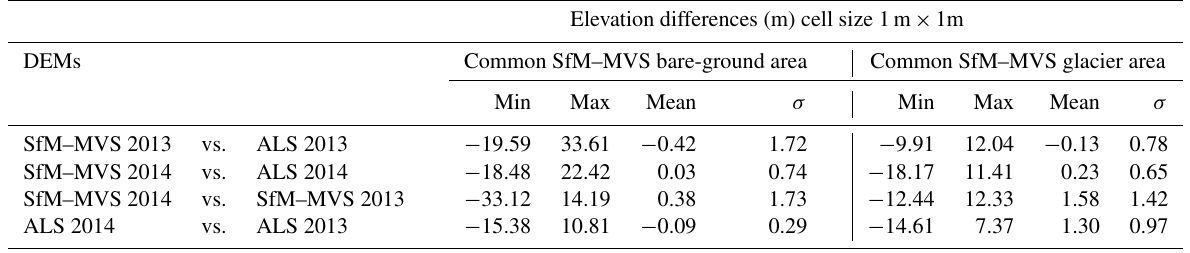
Table 3. Comparison between SfM–MVS-based DEMs and ALS-based DEMs in the common area outside and inside the La Mare Glacier.